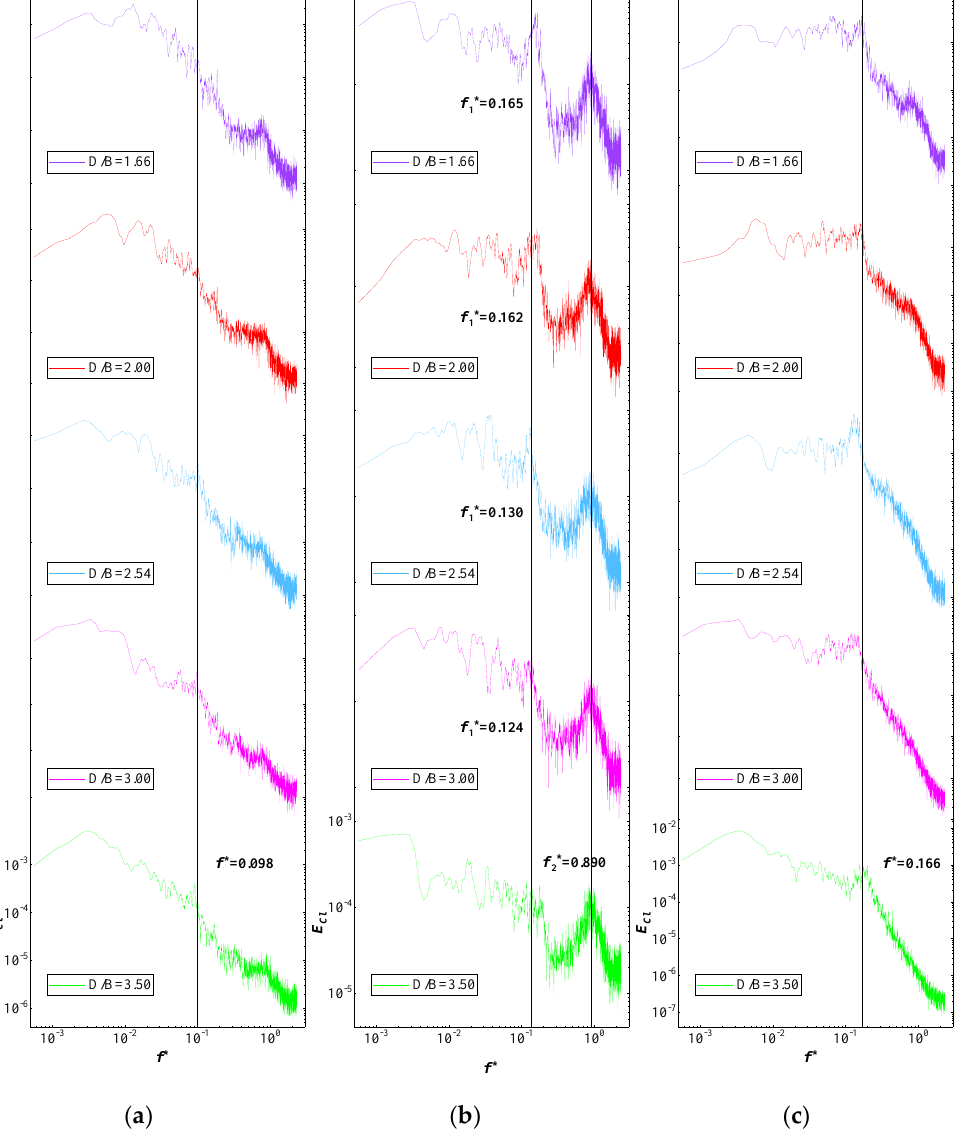
Figure 14. PSD of the lift coefficient for Case 2: ( a ) Vehicle; ( b ) Upstream bridge; ( c ) Downstream bridge.